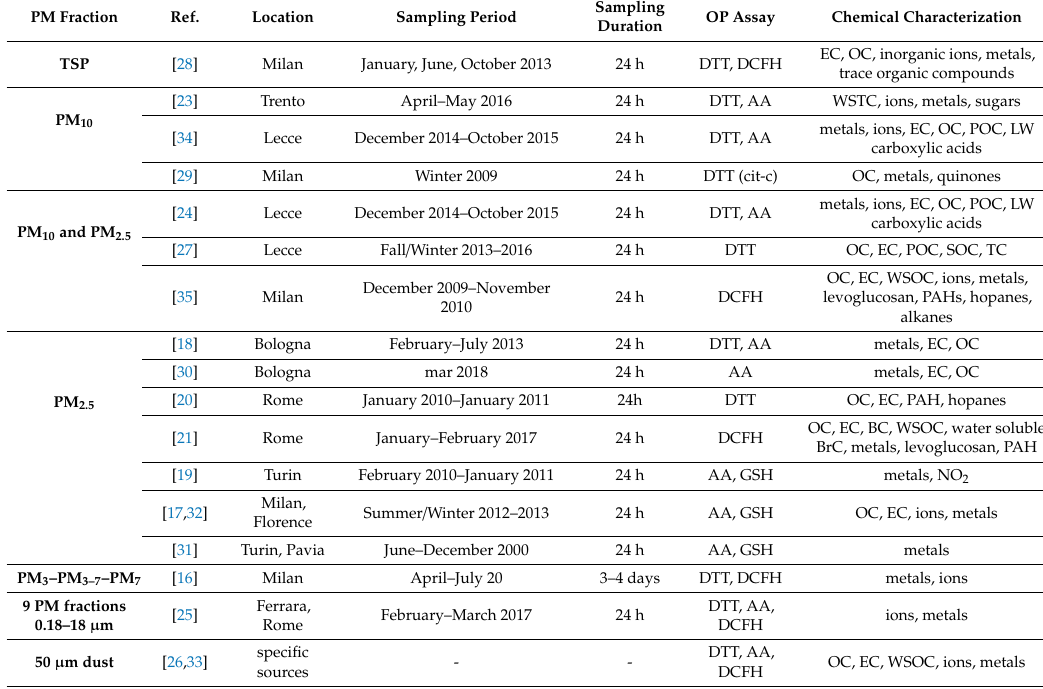
Table 1. Relevant information reported in the reviewed studies, grouped according to particulate matter (PM) dimensional fractions: Site location, period, and duration of PM samples collection, acellular assay used for oxidative potential (OP) measurement, analyzed species for chemical characterization. (TSP: total suspended particles, DTT: dithiothreitol, AA: ascorbic acid, GSH: glutathione, DCFH: 2 (cid:48) ,7 (cid:48) -dichlorofluorescin, EC: elemental carbon, OC: organic carbon, WSOC: water soluble organic carbon, POC: primary organic carbon, SOC: secondary organic carbon, LW: low weight, TC: total carbon, WSTC: water soluble total carbon, PAH: polycyclic aromatic hydrocarbon, BC: black